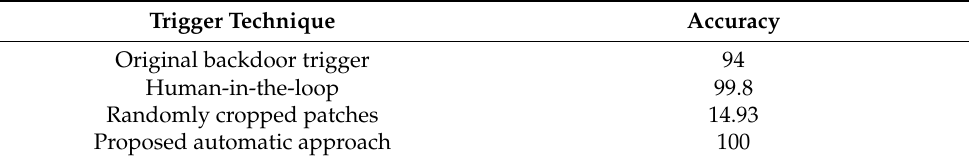
Table 2. The attack success rate of different techniques showing the highest